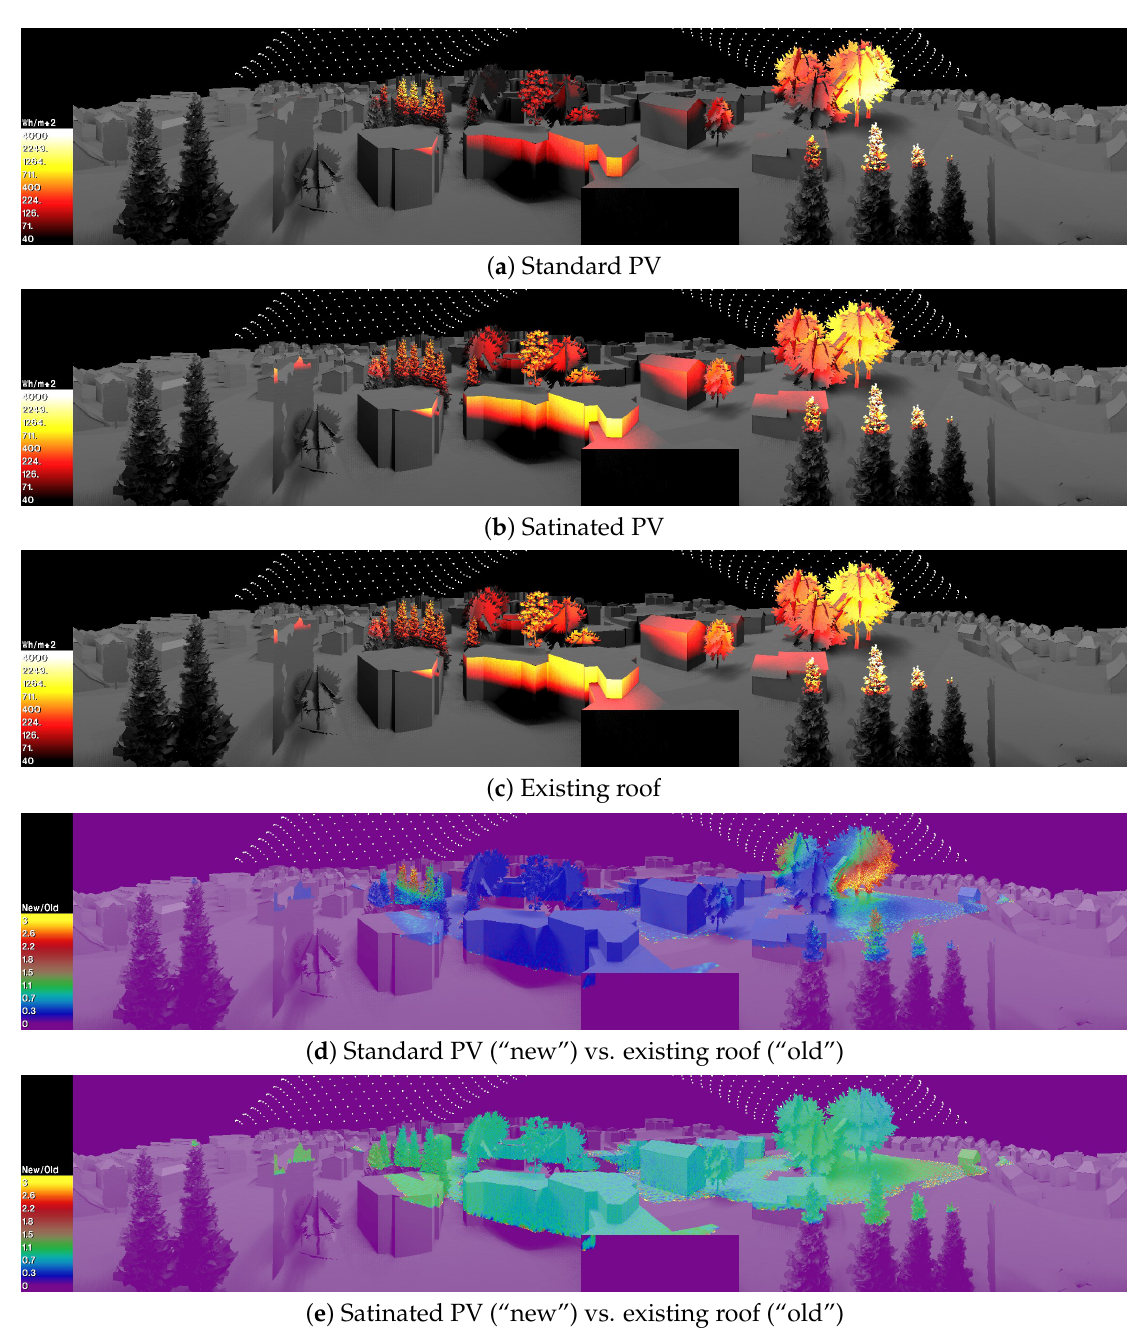
Figure 12. Panoramic views of annual irradiance from standard PV ( a , d ), satinated PV ( b , e ) and existing roof tile ( c ), with centre facing south. ( a – c ) are in absolute units, while ( d , e ) are reflection distributions in relation to the existing roof tile, expressed as irradiance